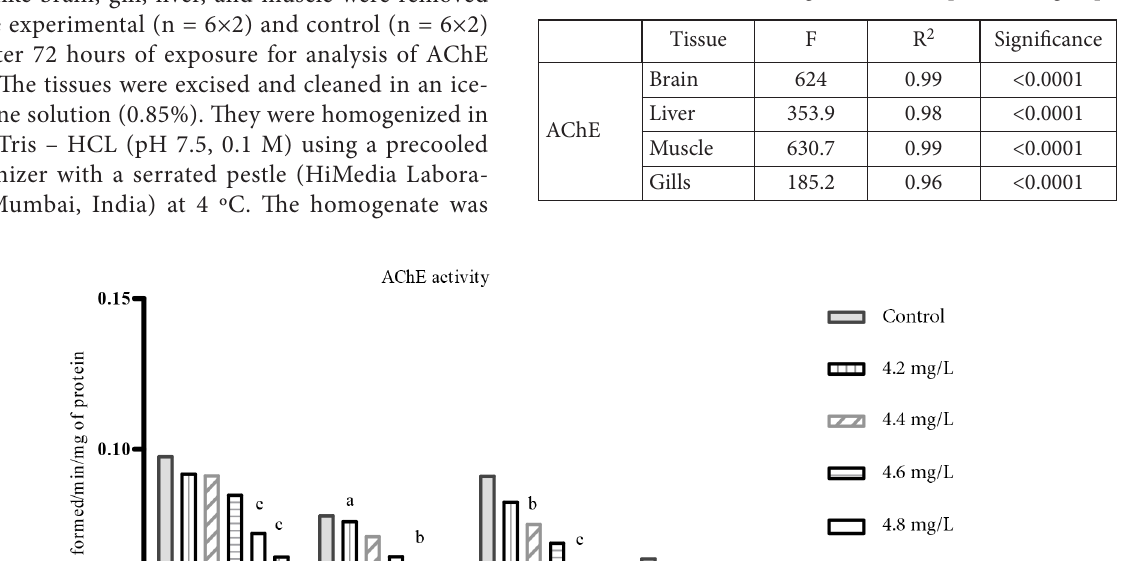
Table 1. ANOVA result of AChE activity of the control group and brain, liver, muscle and gill tissues of experimental group